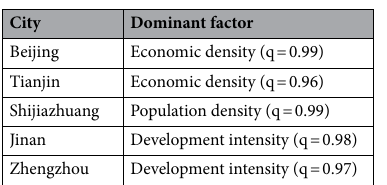
Table 4. Detection result of the dominant factor for each city.